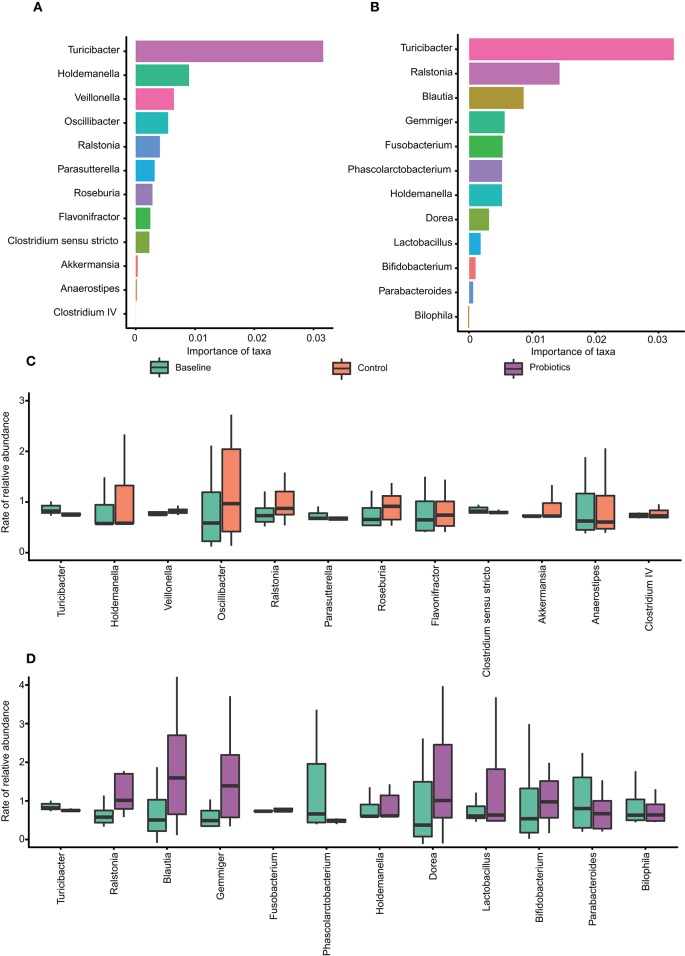
The core taxa selected by the random forest algorithm. (A–B) The feature importance scores of 12 taxa at the genus level, which can explain the variance among groups (baseline vs. control: 74.5%; baseline vs. probiotics: 80%). (A) Baseline vs. control; (B) baseline vs. probiotics. (C–D) The relative abundance of relevant taxa changes between groups. *p < 0.05. The data were processed for standardization using the Z-score method, and the y-axis represents the rate of change in relative abundance.